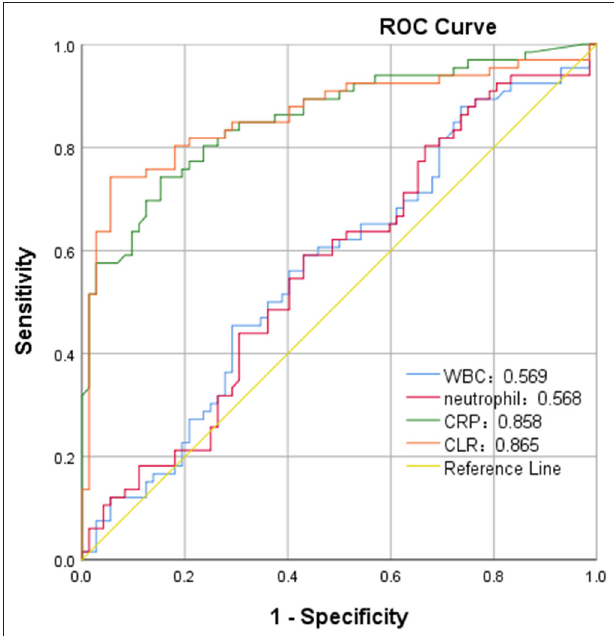
FIGURE 3 | ROC curve of C-reactive protein to lymphocyte ratio (CLR) in predicting poor outcome of patients with aSAH in mild group (Hunt-Hess of ≤ 3).